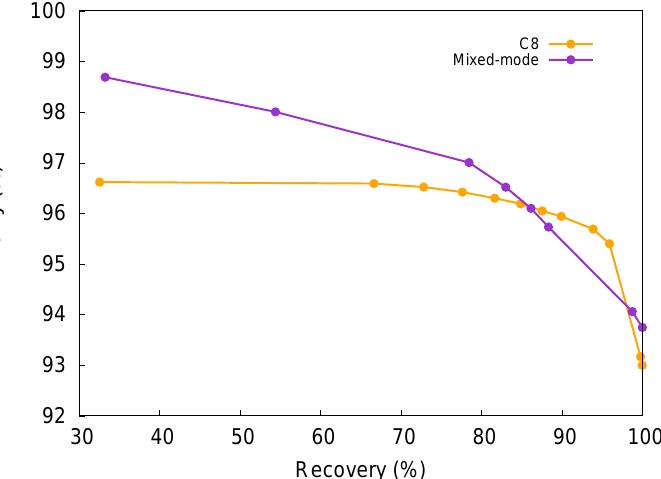
Figure 3. Comparison between the Pareto curves obtained with the two columns in the same chromatographic conditions (C8: orange; MM: violet).